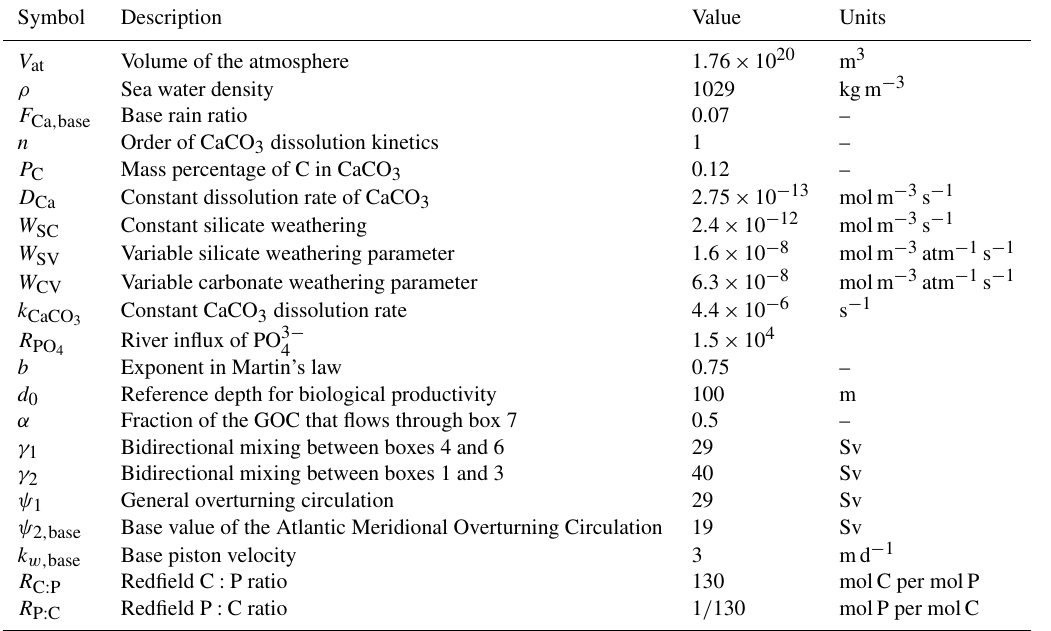
Table A1. Symbol (column 1), description (column 2), value (column 3), and units (column 4) of the general parameters used in our model.